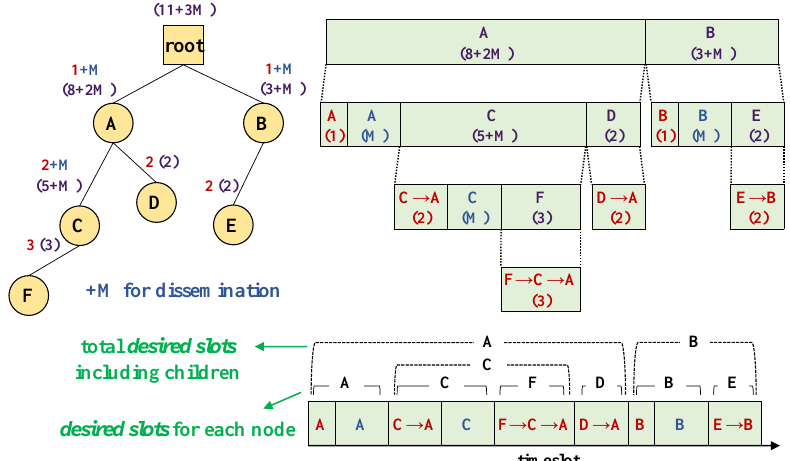
Figure 2. SCoRe’s scheduling process